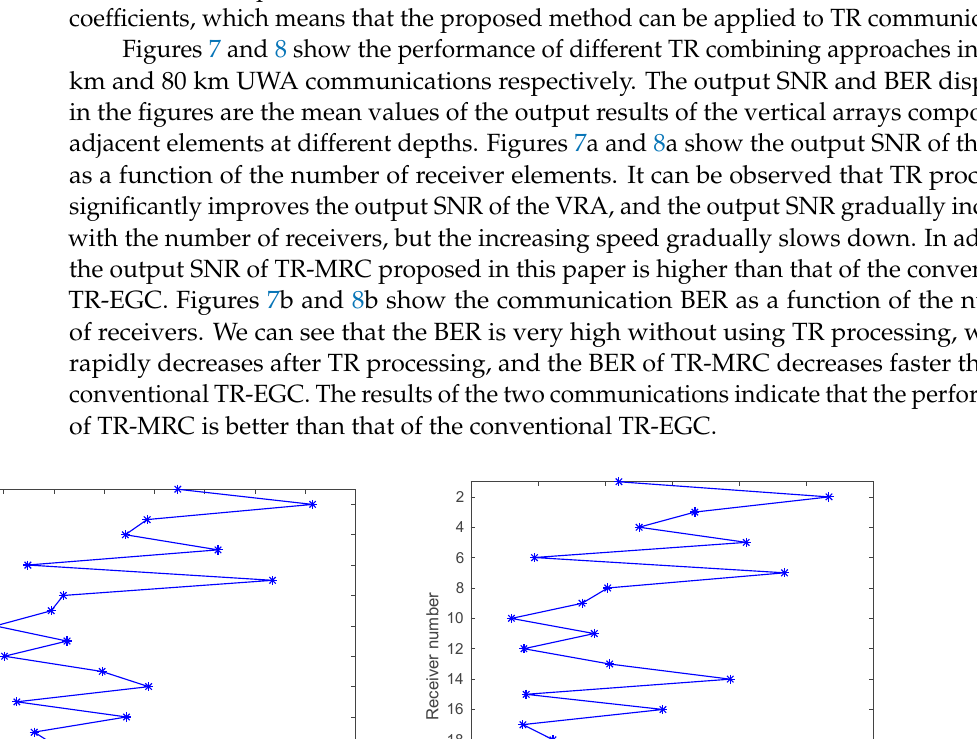
Figure 4. Performance of single element TR processing: input SNR, output SNR and temporal focusing gain. ( a ) 50 km UWA communication; ( b ) 80 km UWA communication.